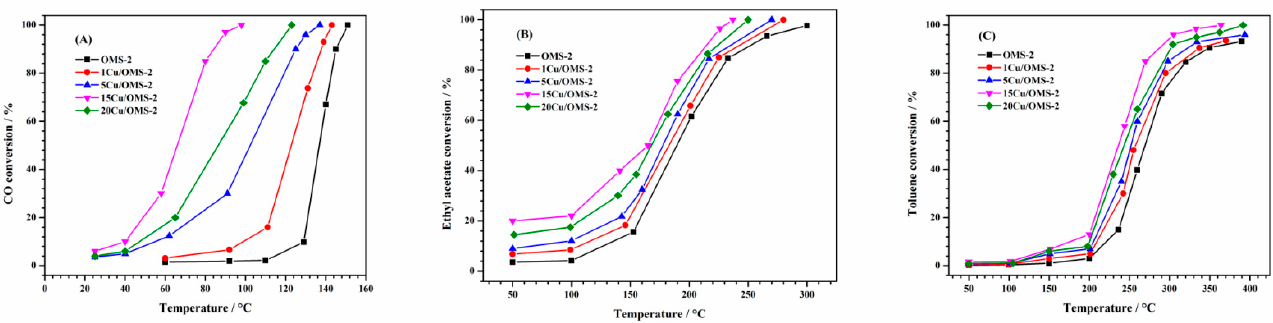
Figure 8. Catalytic activities for the oxidation of ( A ) CO (10,000 ppm) at SV = 30,000 mL/(g h), ( B ) ethyl acetate (2000 ppm) at SV = 120,000 mL/(g h), and ( C ) toluene (2000 ppm) at SV = 120,000 mL/(g h) over the OMS-2 and x Cu/OMS-2 samples.